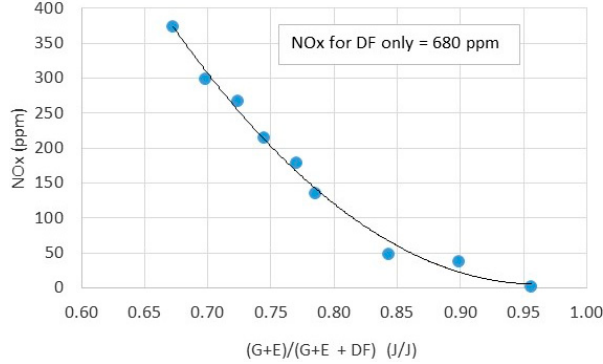
Figure 6. Temperature of exhaust gases vs. 𝐺 + 𝐸 fraction by energy content.